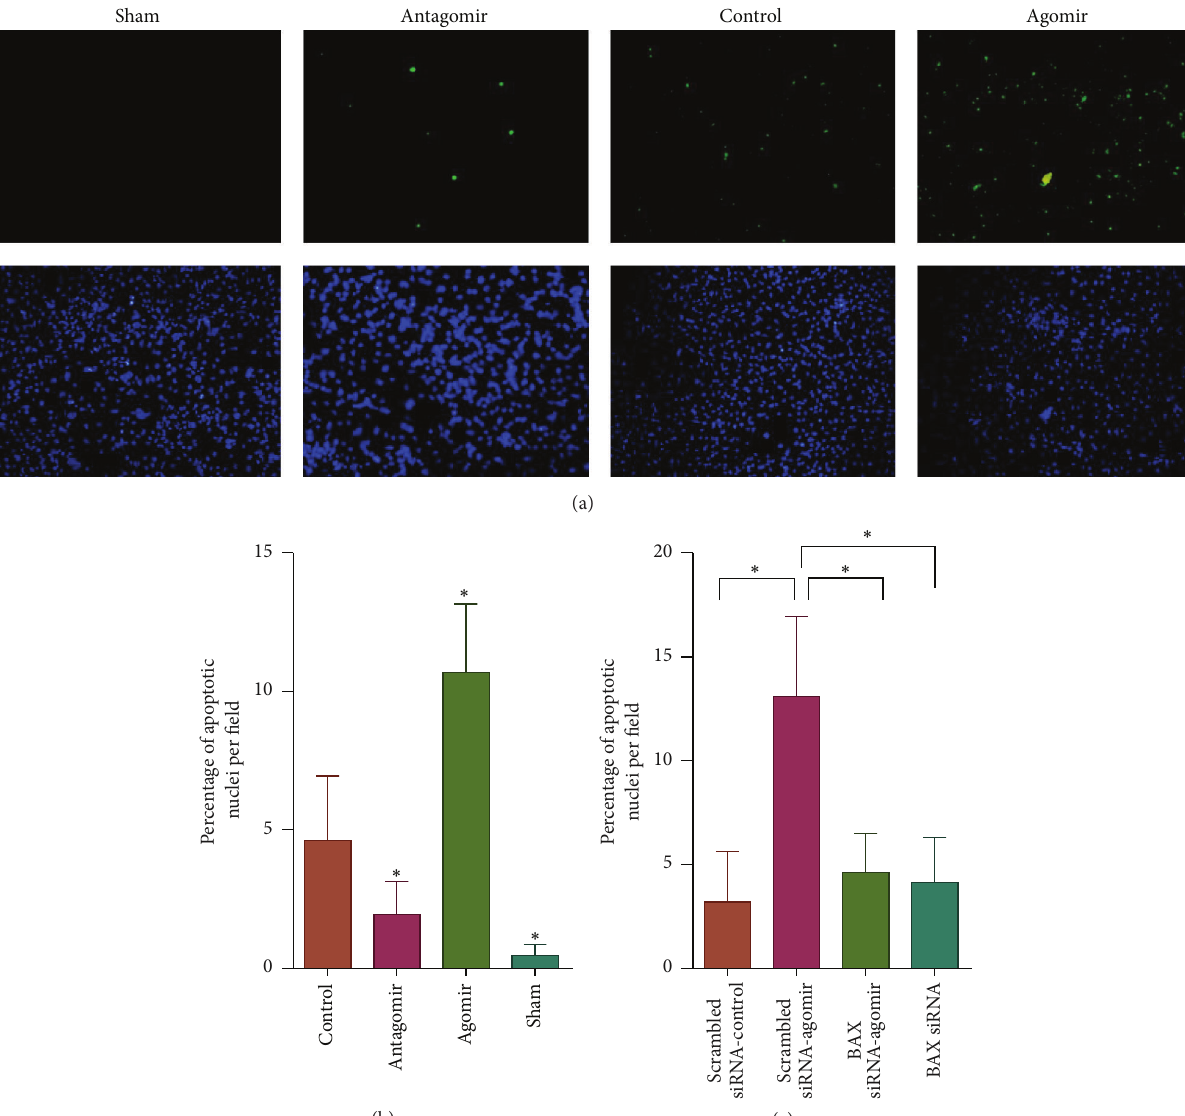
Figure 2: miR-208a upregulation promotes cardiomyocyte apoptosis during ischemia and its silencing attenuates myocyte apoptosis ( ∗ 𝑝 < 0.05 ). (a) Representative TUNEL stained images of neonatal cardiomyocytes showing increased apoptosis following agomir treatment